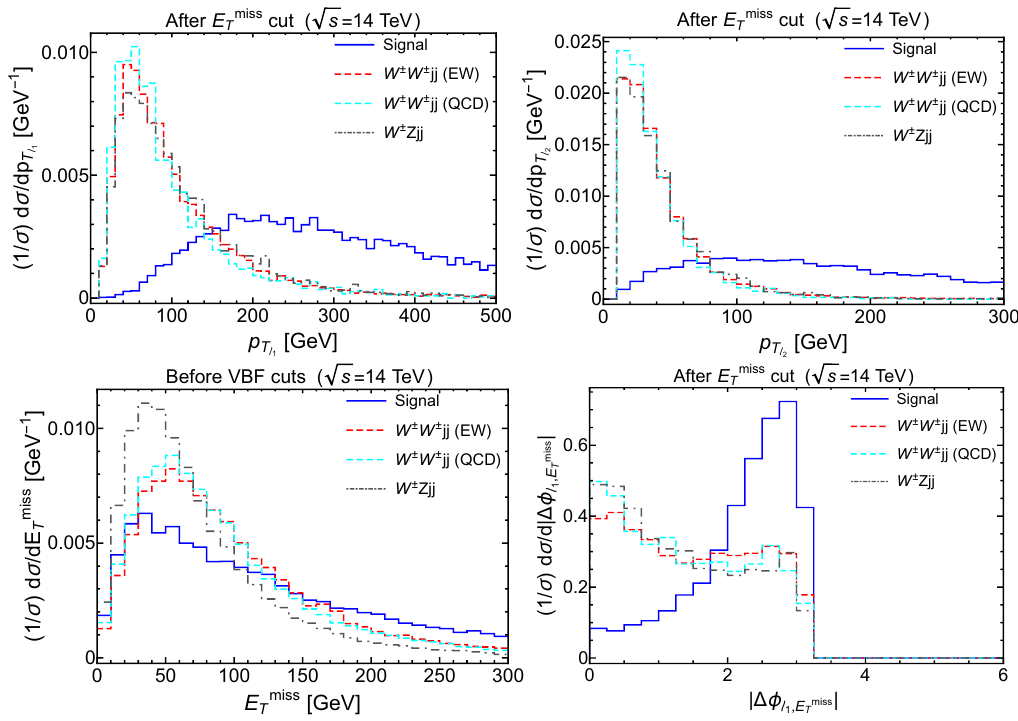
Figure 7 . Kinematic distributions of the signal and SM backgrounds W (cid:6) W (cid:6) jj (EW), W (cid:6) W (cid:6) jj (QCD) and W (cid:6) Zjj after the E miss cut. The top left and right panels are respectively for the p T T distributions of the leading lepton ‘ 1 and the sub-leading lepton ‘ 2 , and the lower left and right panels respectively for the missing transverse energy E miss and the angular separation j (cid:1) (cid:30) j . ‘ 1 E miss T T Only the E miss distribution is shown before VBF cuts. T